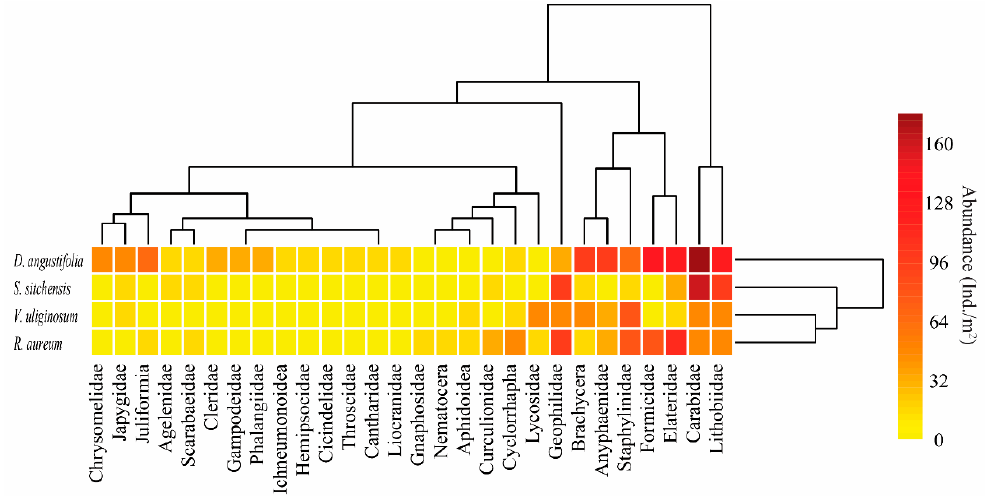
Figure 3. Abundance heatmap of log (x+1)-normalized soil macro-arthropods in the various habitats; dendrogram of sample sites based on similarity along right axis; dendrogram of soil macro-arthropods taxa based on similarity along upper axis. The colors represent the abundance of soil macro-arthropods.